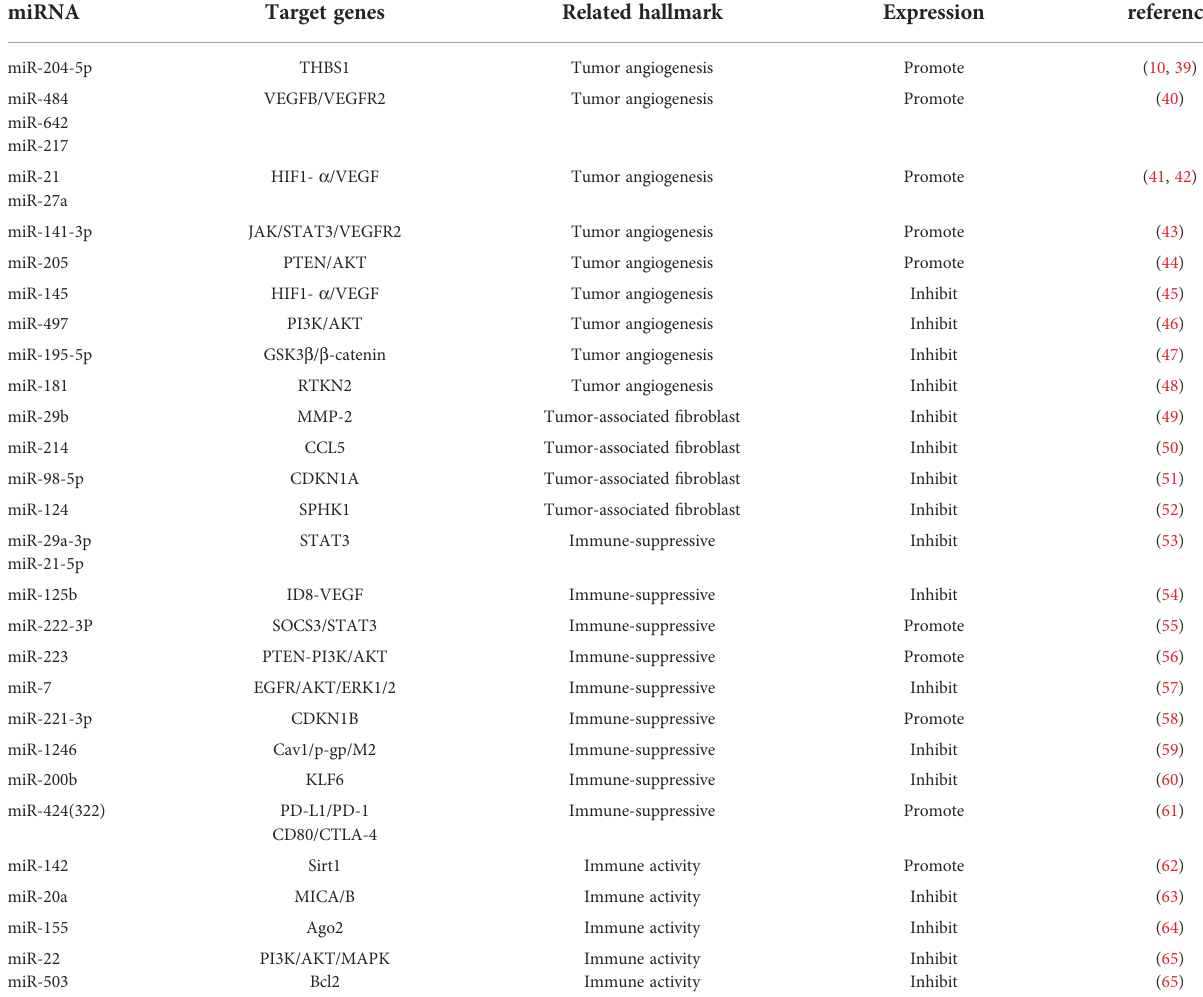
TABLE 1 Detailed information of miRNAs targeting TME to regulate ovarian cancer. miRNA Target genes Related hallmark Expression